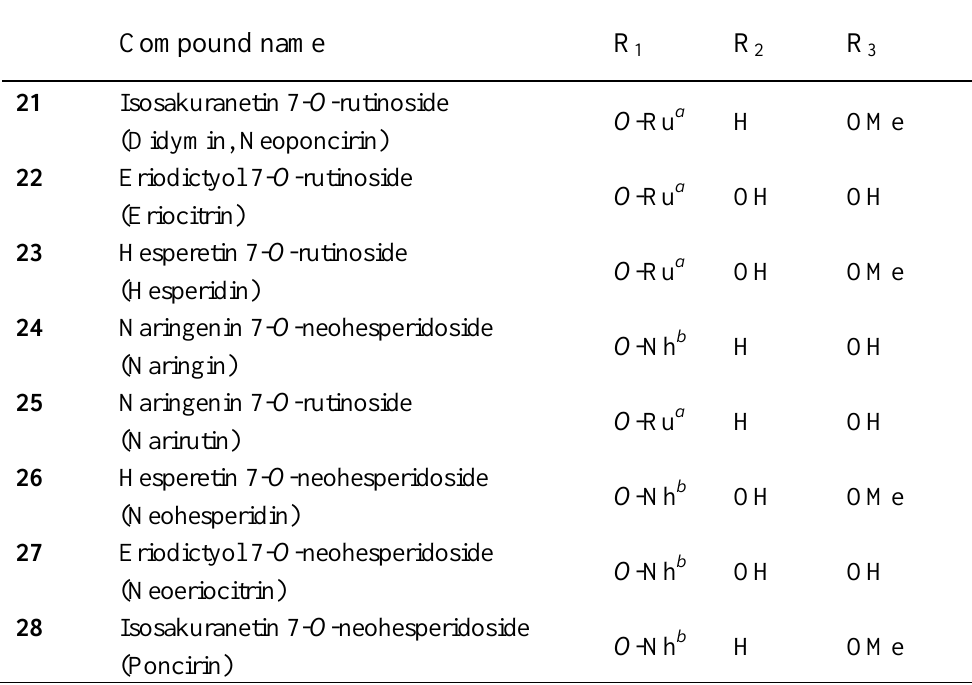
Table 4. Flavanone- O -glycosides.